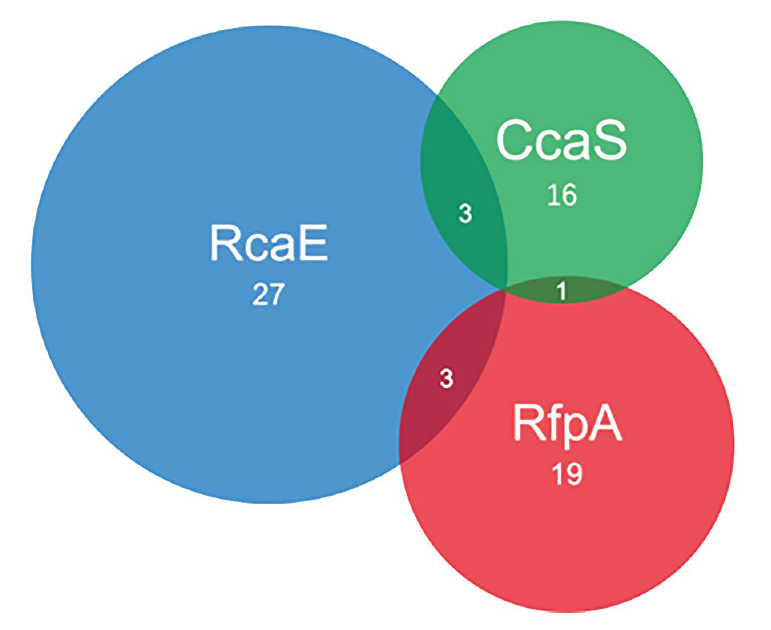
Figure 2. Venn diagram summarized the numbers of photoreceptors from 65 selected cyanobacterial genomes. The numbers in the overlayed regions represent the cases of co-existing photoreceptors. Green, CcaS; Blue, RcaE; Red, RfpA. Table 1. Co-existing photoreceptors and chromatic acclimation